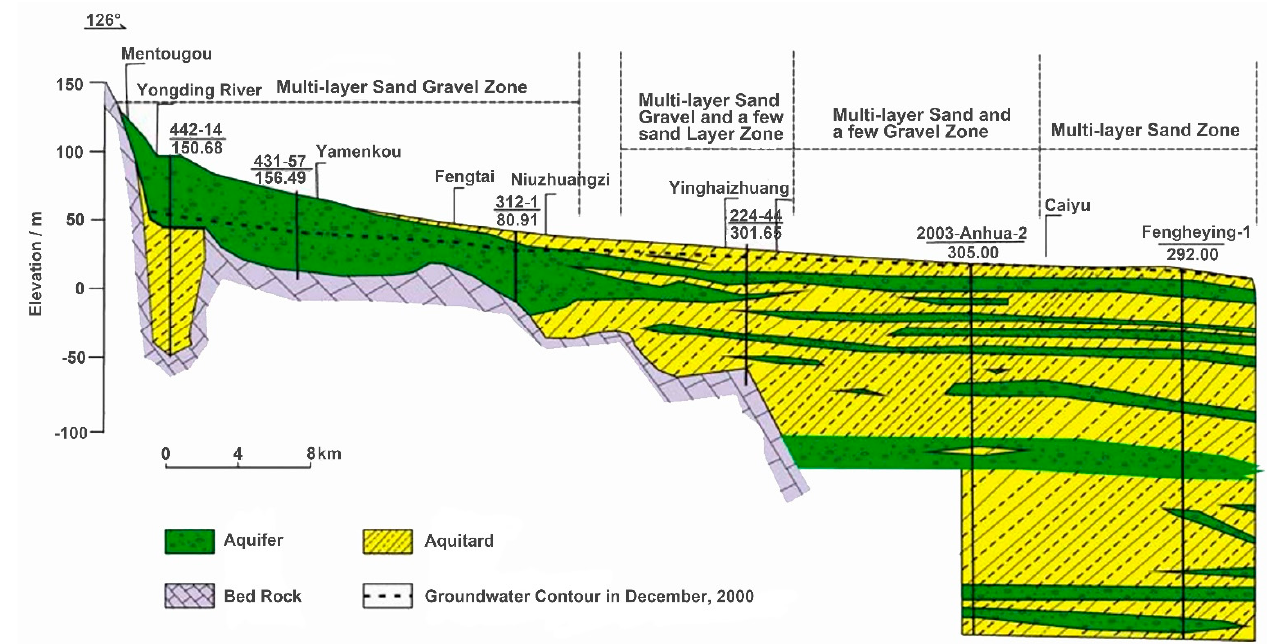
Figure 4. Hydrogeological profile in the Yongding River alluvial fan (adapted from Figure 2 in the study by Huan et al. [28] ).